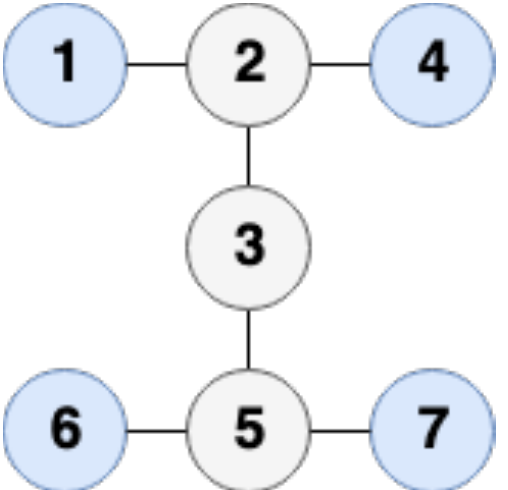
Figure 6. The tree graph of the barycenter problem, with leaves L marked in